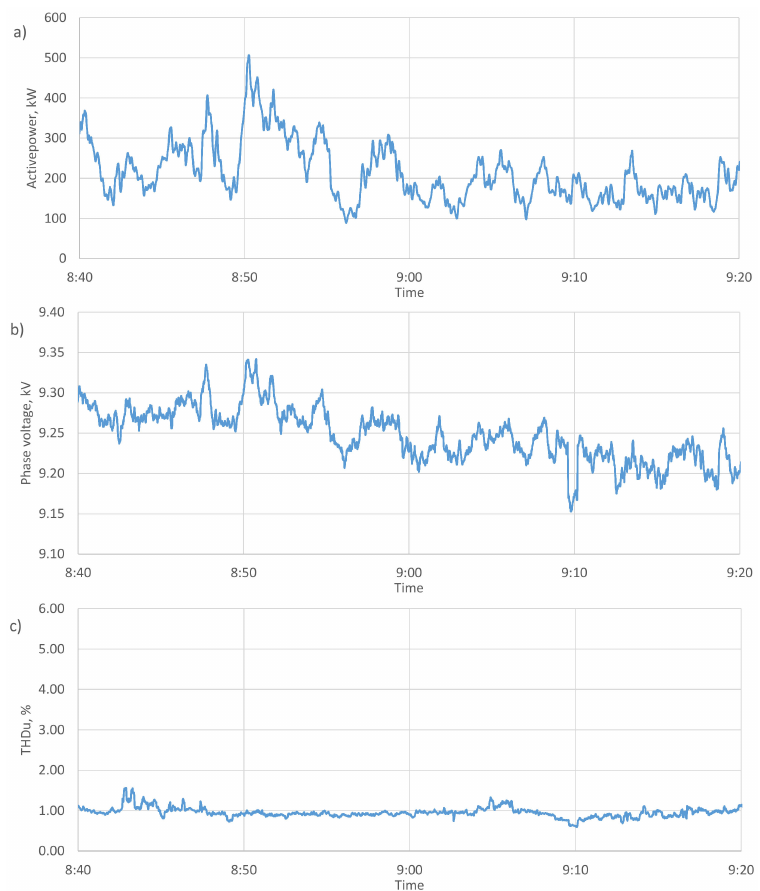
Figure 19. Exemplary one-hour waveforms for the wind farm: ( a ) active power, ( b ) phase voltage—RMS value; ( c ) voltage